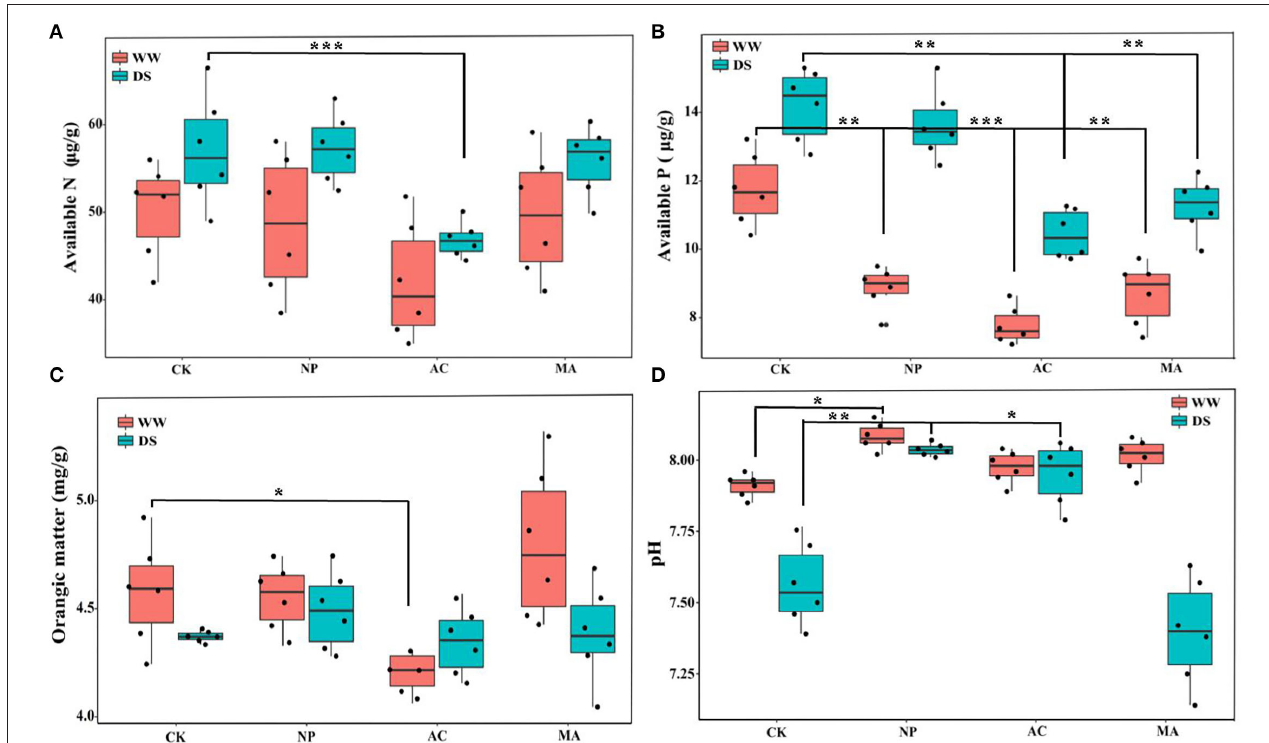
FIGURE 4 | Effects of different dark septate endophyte (DSE) on soil physicochemical parameters of Lycium ruthenicum seedlings. CK, non-inoculated plants; NP, plants inoculated with Neocamarosporium phragmitis ; AC, plants inoculated with Alternaria chlamydospore ; MA, plants inoculated with Microascus alveolaris ; WW, well-watered; DS, drought stress, respectively. Available N content of rhizosphere soil (A) , Available N content of rhizosphere soil (B) , Orangic matter content of rhizosphere soil (C) , and pH of rhizosphere soil (D) . The * symbol indicates the significant difference P < 0.05. The ** symbol indicates the significance level intervenes between P < 0.01. The *** symbol indicates difference is very significant, P < 0.001.